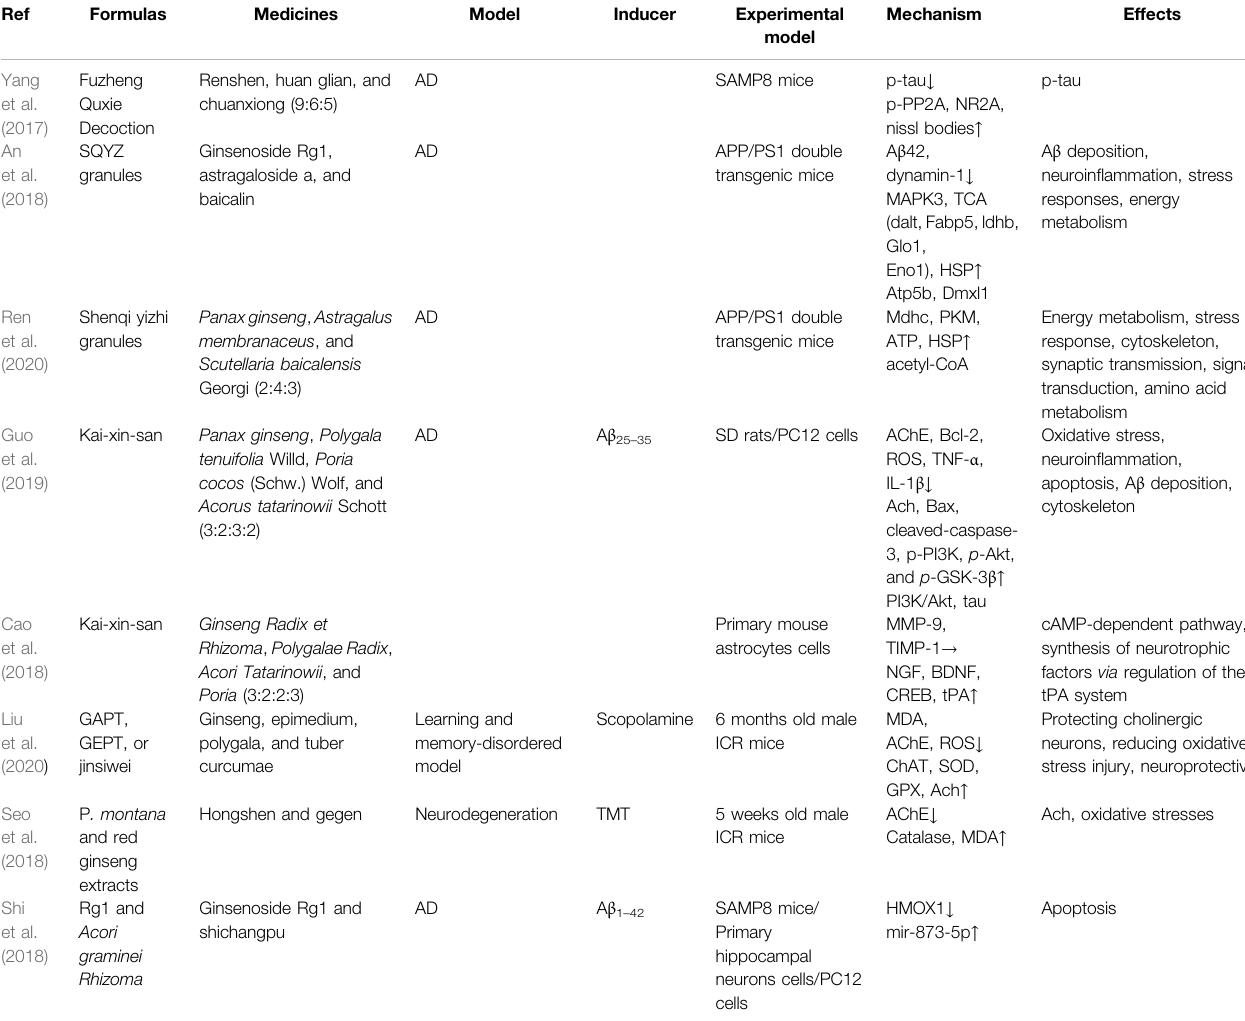
TABLE 3 | Summary of effects and mechanisms of formulas containing ginseng in neuronal cells and animal models.